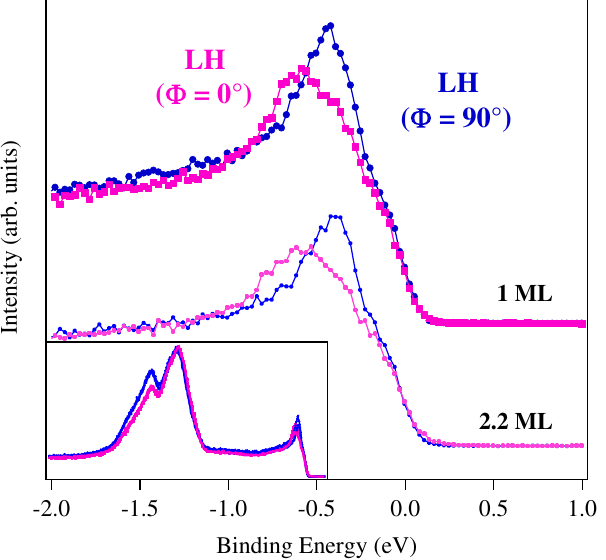
Figure 6. EDCs measured after deposition of 1 and 2.2 layers of Ag on C-c(3 √ 2 × √ 2):Fe. The Blue(magenta) curve corresponds to the measurements with A perpendicular(parallel) to the steps. The same SS as in 4 are present, confirming the passivation effect of the carbon reconstructed surface. The inset shows the EDC energy range measured [ − 14, 1] eV showing the Ag valence